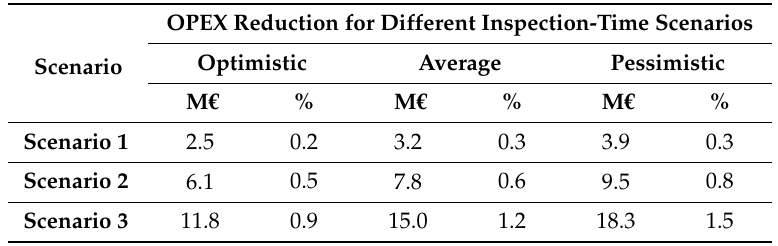
Table 18. Lifetime OPEX reduction due to SHM implementation and inspection time.